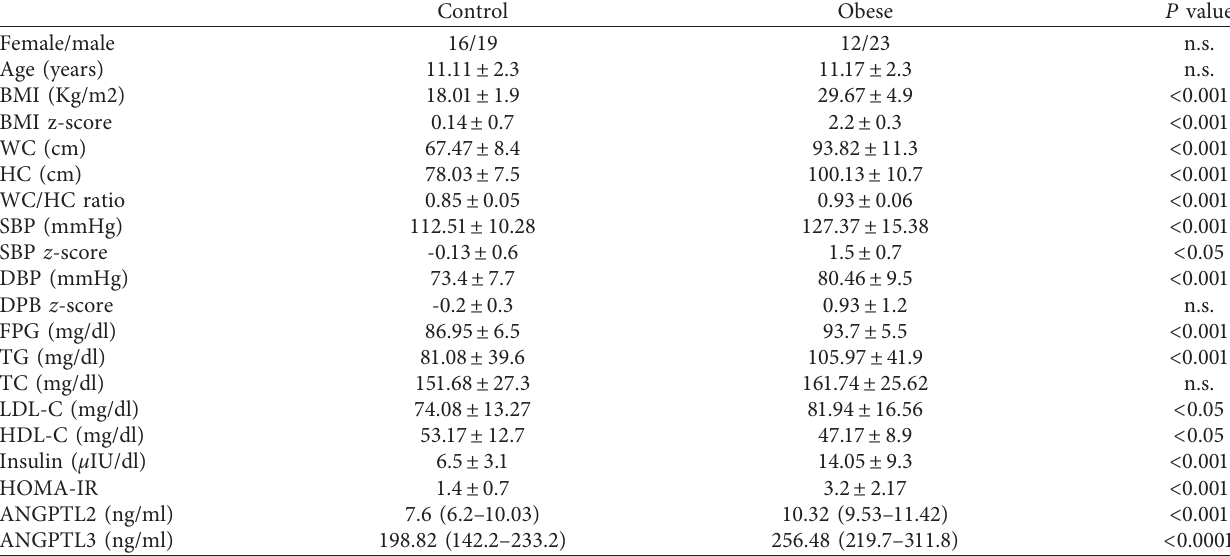
Table 1: Anthropometric and biochemical characteristics of the children and adolescents in the control and obese groups. Control Obese P value